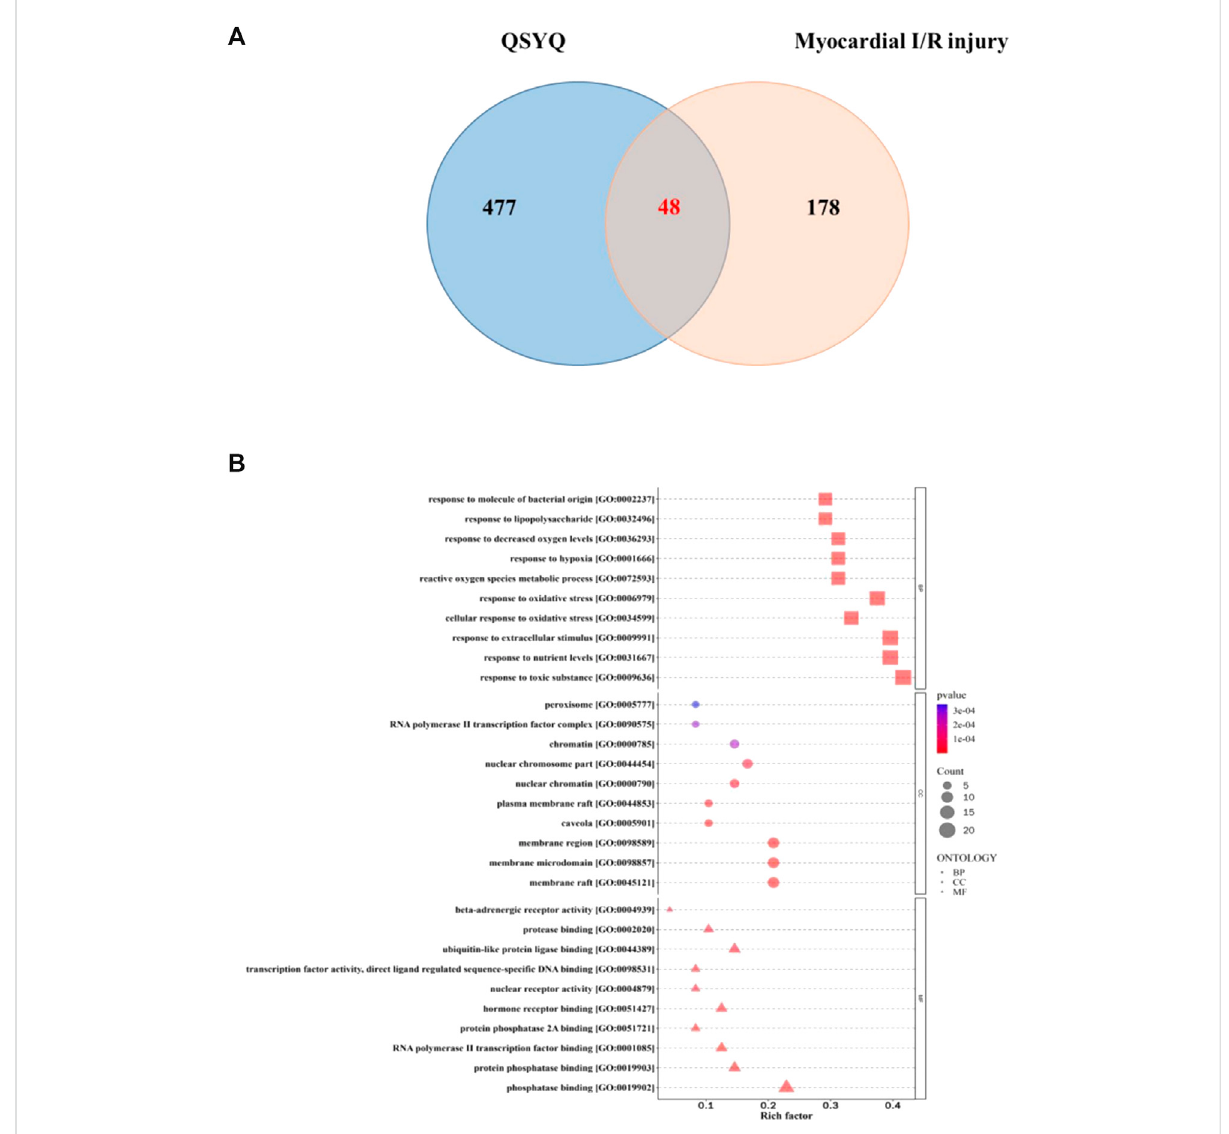
FIGURE 1 Functional analysisofQSYQagainstmyocardialI/R injury. (A) :MatchingmapofQSYQ-targeted genesandmyocardial I/Rinjury-targetd genes; (B) :GO functional enrichmentanalysis: thebiological processes, cellular component, and molecular function termswere distributedin the ordinate and the abscissa represented rich